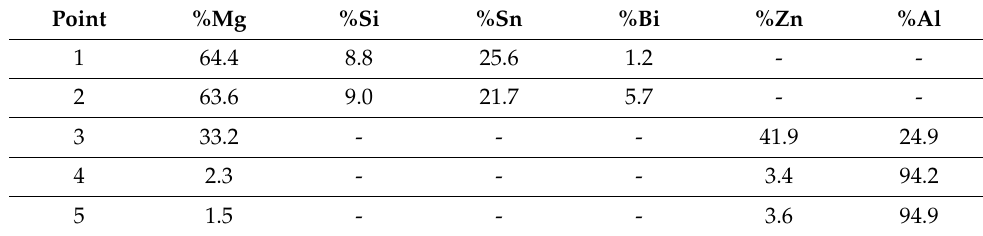
Figure 2. SEM images of different areas of the interface after contacting of a Zn-coated Al foil with a Mg 2 (Si,Sn) pellet: ( a ) first side interface, ( b ) second side interface, ( c ) zoom-in and point analysis of the reacted area in ( b ). Table 4. EDX analysis of the points indicated in Figure 2. The quantities are given in